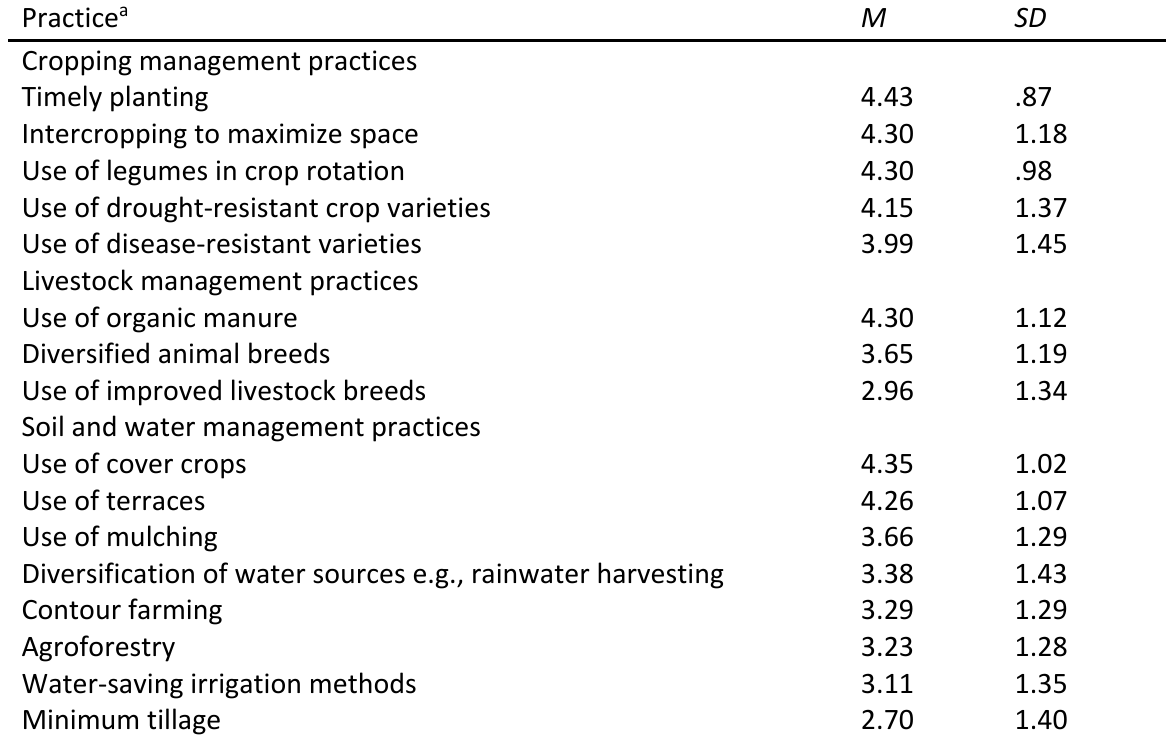
Descriptive Statistics for Adoption of Climate-Smart Practices (N = 115) Practice